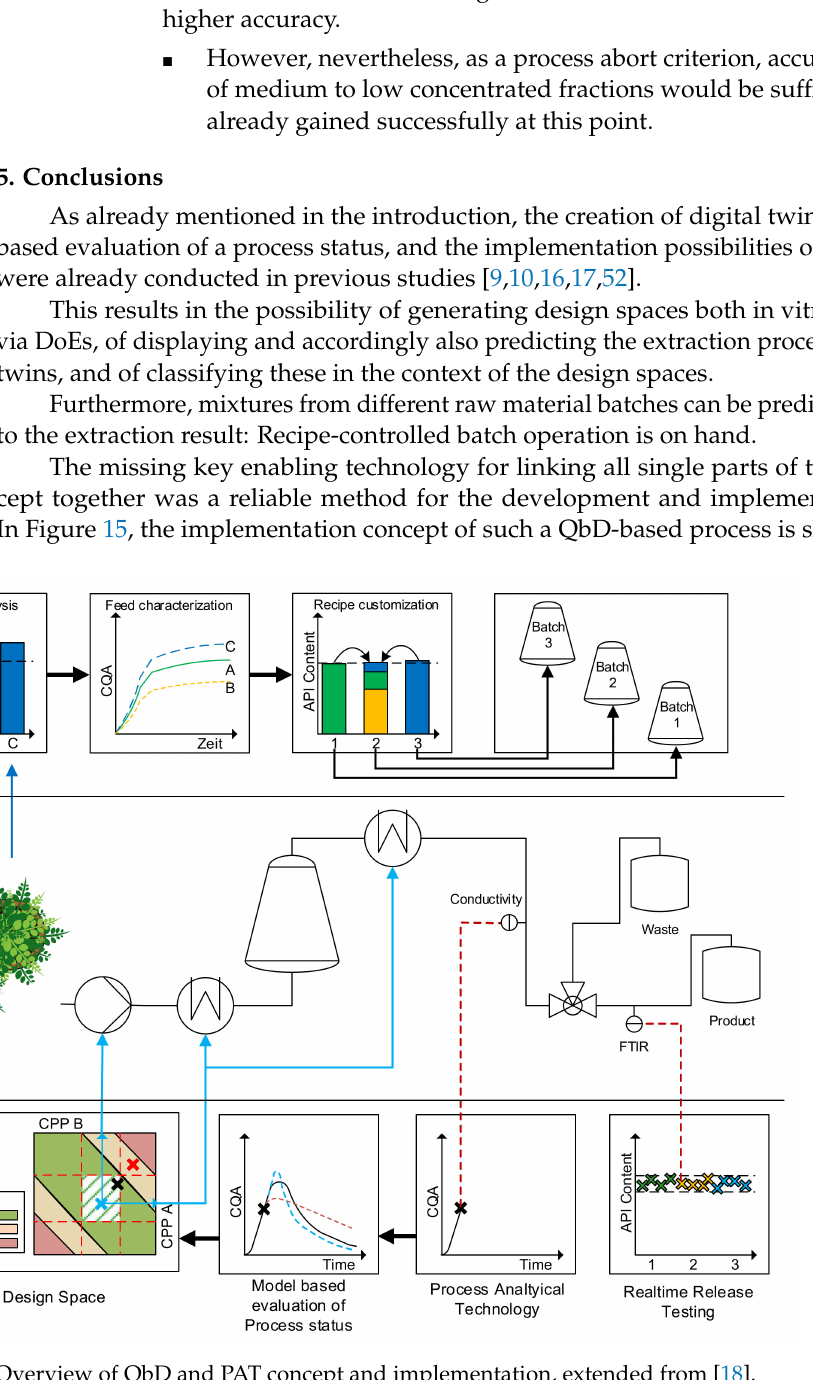
Figure 15. Overview of QbD and PAT concept and implementation, extended from [18]. This missing link between the process level and the digital twin with the design space level, the establishment of a method for PAT development, was conducted in this study. Therefore, the complex mixture was divided into different component groups based on chemical